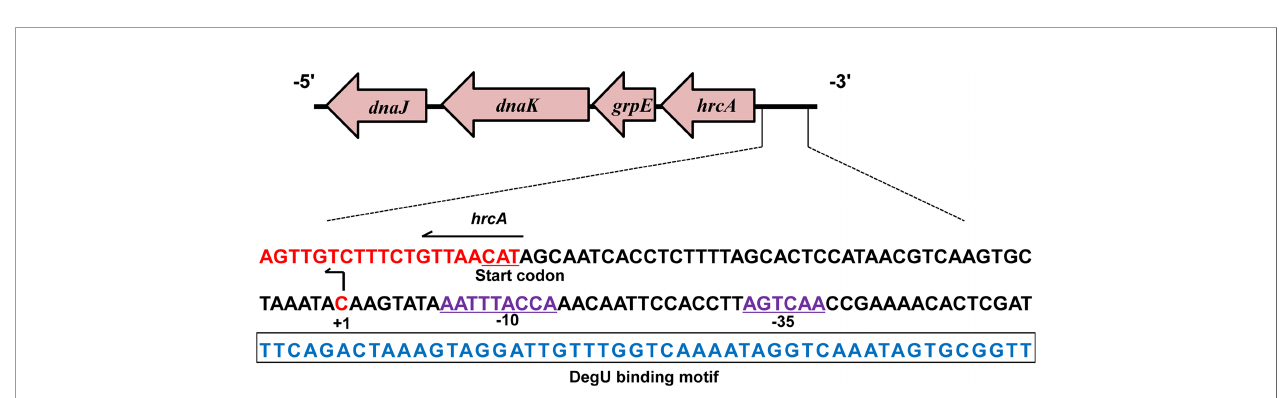
FIGURE 4 | Characterizing the DegU Binding Site. DNA sequences of the hrcA promoter region. The DegU-binding site is shown in blue nucleotides boxed in black. The -35 and -10 regions are underlined and shown in purple. The TSS is denoted by +1 (bent arrow). The start codon of hrcA is shown in red. In panels A, experiment was performed at least three times and representative result is